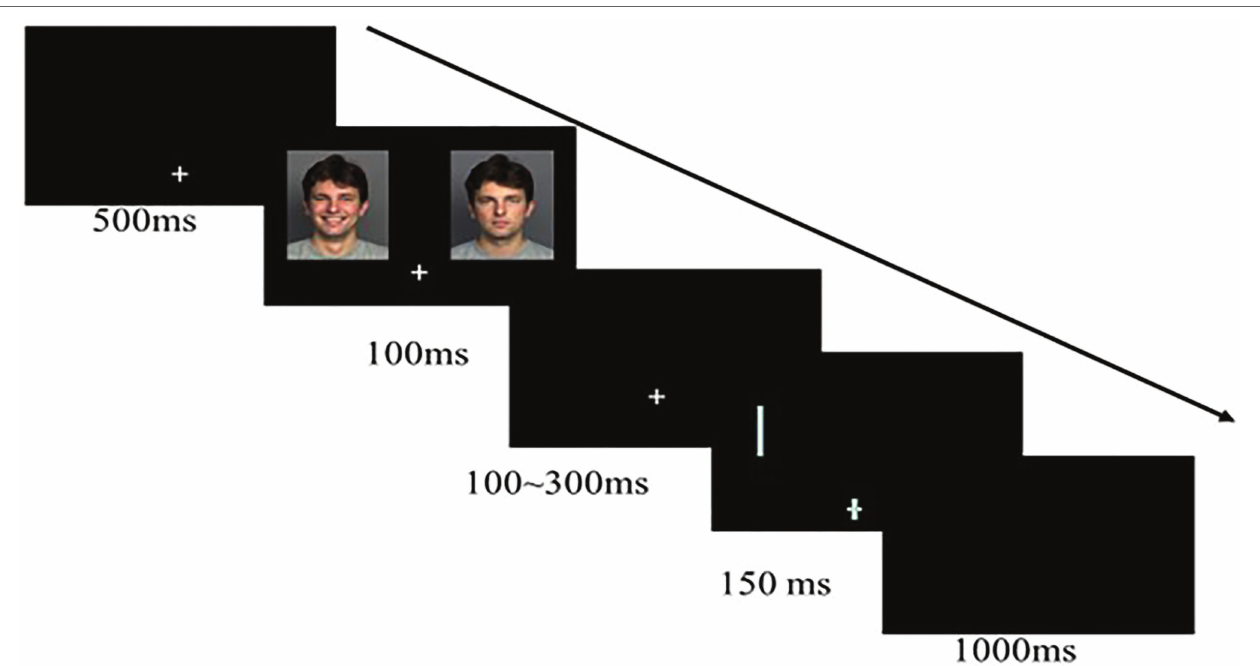
FIGURE 1 | Example trial sequence of the Go/No-go detection